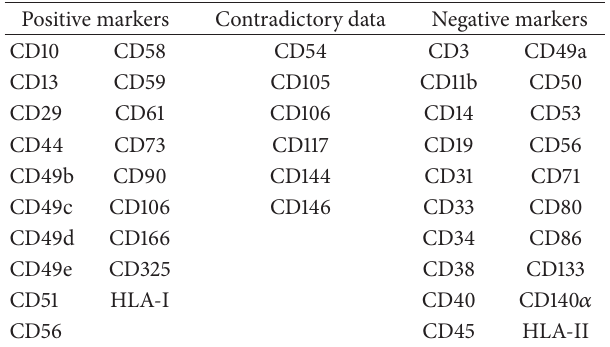
Table 1: The expression of cell surface markers on UC-MSCs (according to [2, 7–9]).